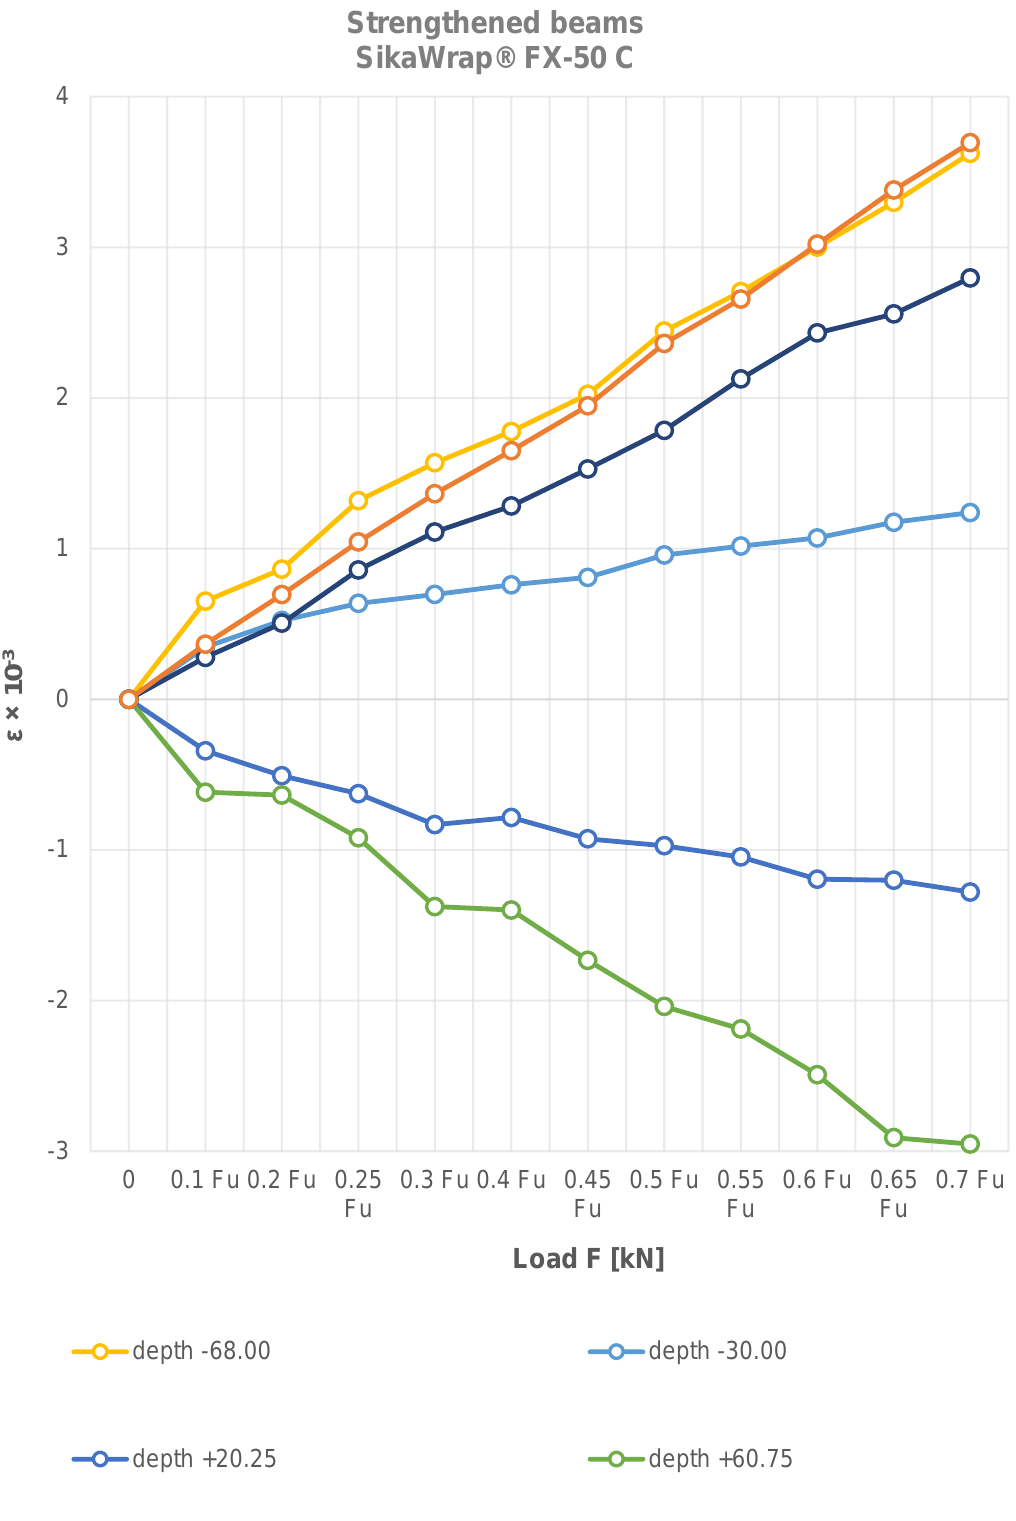
Figure 7. The distribution of deformation in timber beams and FRP materials at the section height.